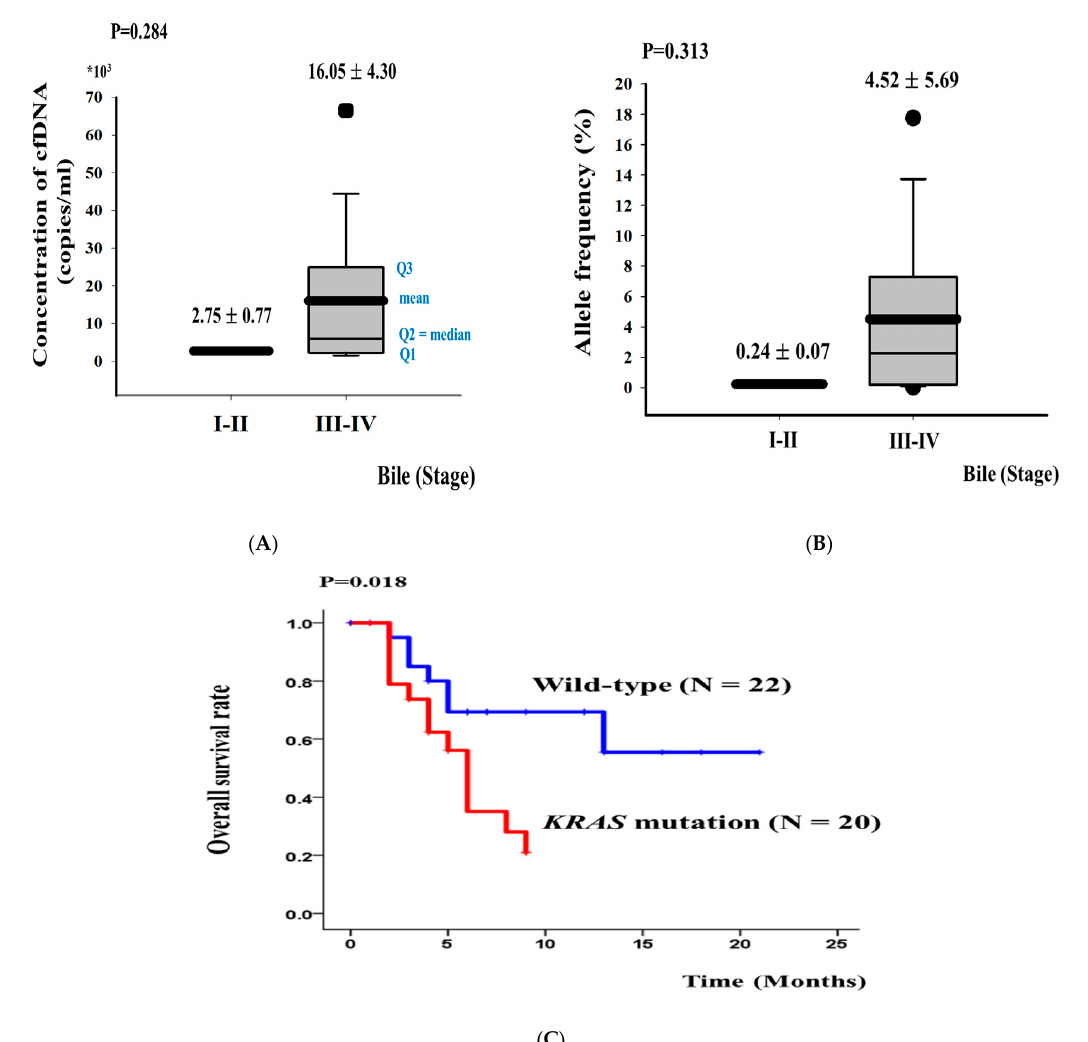
Figure 1. KRAS ctDNA concentrations and AF in bile according to clinical stages ( A , B ) and 2-year survival in patients with mutated or wild-type KRAS ( C ). Two-year survival was estimated with the Kaplan–Meier model.